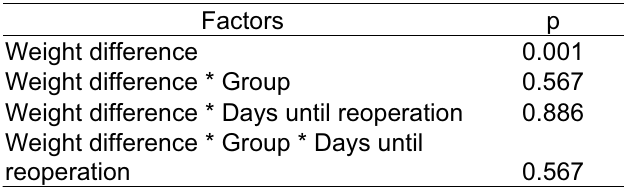
TABLE 2 – Repeated-measures ANOVA with two grouping factors